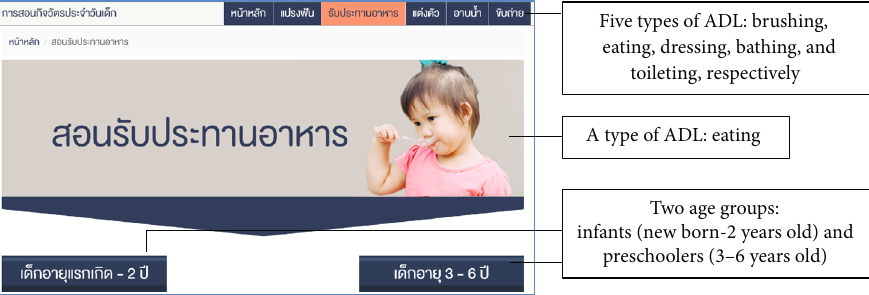
Five types of ADL: brushing,